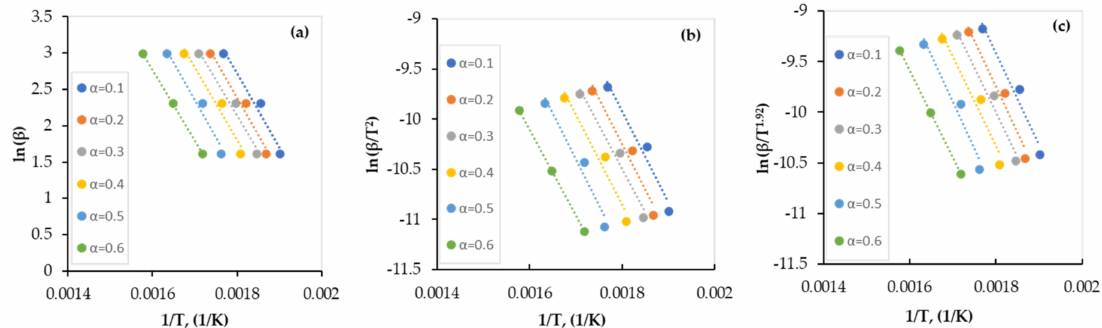
Figure 3. Regression lines of the experimental data of the PVC pyrolysis (stage I) by: ( a ) FWO, ( b ) KAS, and ( c ) Starink models.